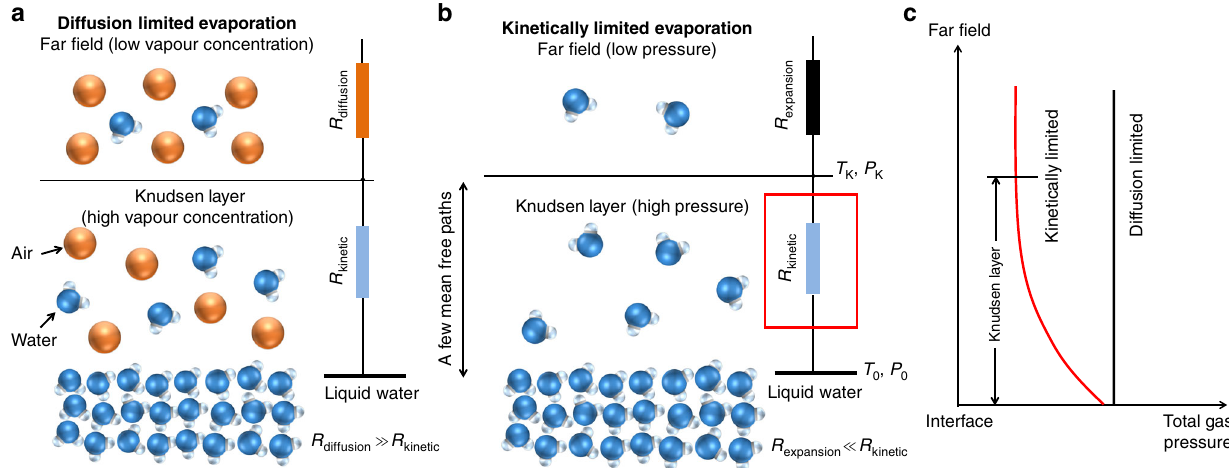
Fig. 1 Physical picture of evaporation driven by different mechanisms. a Schematic of evaporation in air (not to scale): the far fi eld vapour concentration is lower than the concentration at the interface and the transport resistance associated with gas diffusion ( R diffusion ) is much greater than the resistance across the Knudsen layer ( R kinetic ). b Schematic of evaporation in vapour (not to scale): the far fi eld pressure is lower than the pressure at the interface and the transport resistance associated with gas expansion ( R expansion ) is much smaller than R kinetic , which allows us to focus on R kinetic in this study (red box). c Sketch of total gas pressure distribution for diffusion limited and kinetically limited evaporation (not to scale): there is no variation in the total gas pressure when evaporation is diffusion limited; in kinetically limited evaporation, the evaporation is driven by the pressure difference which is mainly distributed across the Knudsen